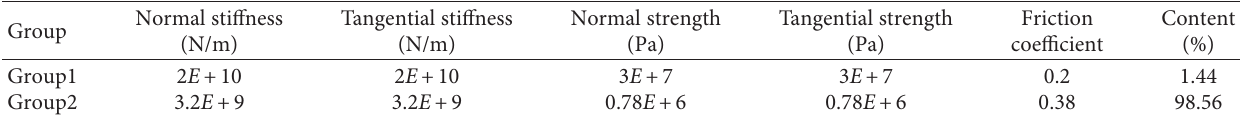
Figure 9: Different types of numerical models of coal samples: (a) finite-element mesh model of sample and (b) discrete element model of sample. Table 1: Calculation parameters for numerical